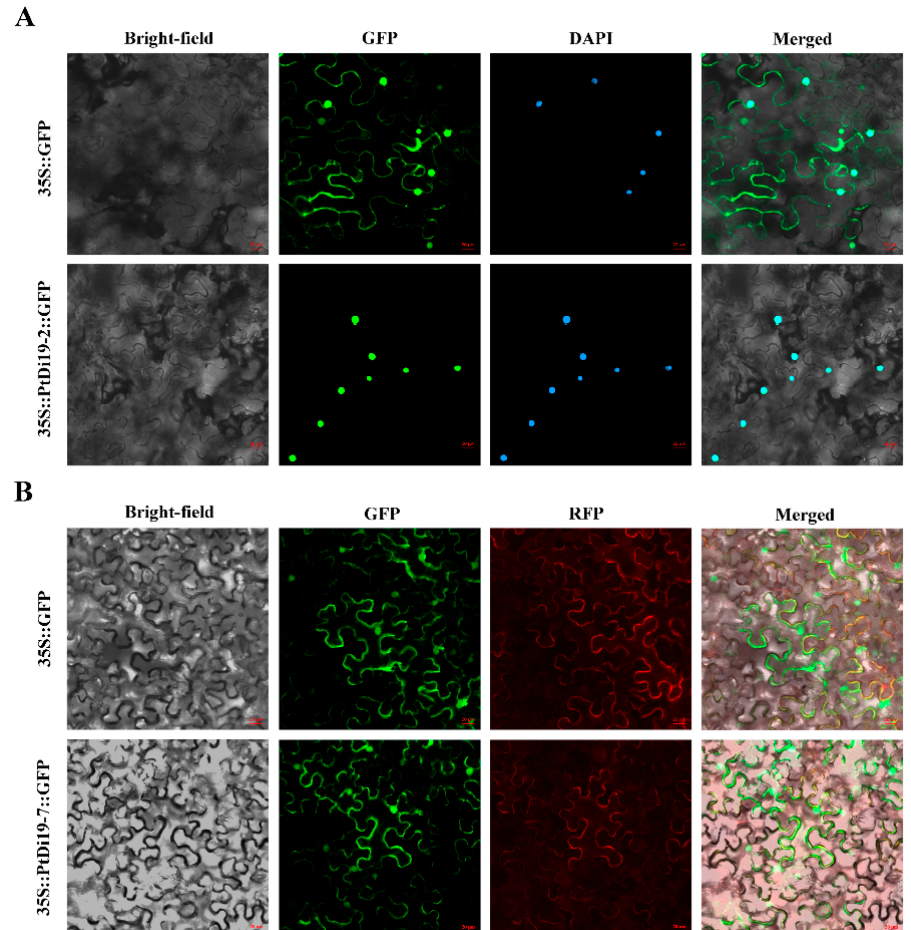
Figure 5. Subcellular localization of PtDi19–2 and PtDi19–7 in tobacco leaves. ( A ) The control and 35S::PtDi19–2::GFP fusion protein was separately expressed in tobacco leaves and observed by the use of a fluorescence microscope. The signal of the GFP channel exhibits a green color, and DAPI staining for the nucleus presents as a blue fluorescence; the bright field was jointly used for forming the merged channel. ( B ) The control and 35S::PtDi19–7::GFP fusion protein were separately expressed in tobacco leaves and observed by the use of a fluorescence microscope. The signal of the GFP channel exhibits a green color, and RFP channel exhibits red fluorescence; the bright field was jointly used for forming the merged channel. Scale bars = 20 µm.